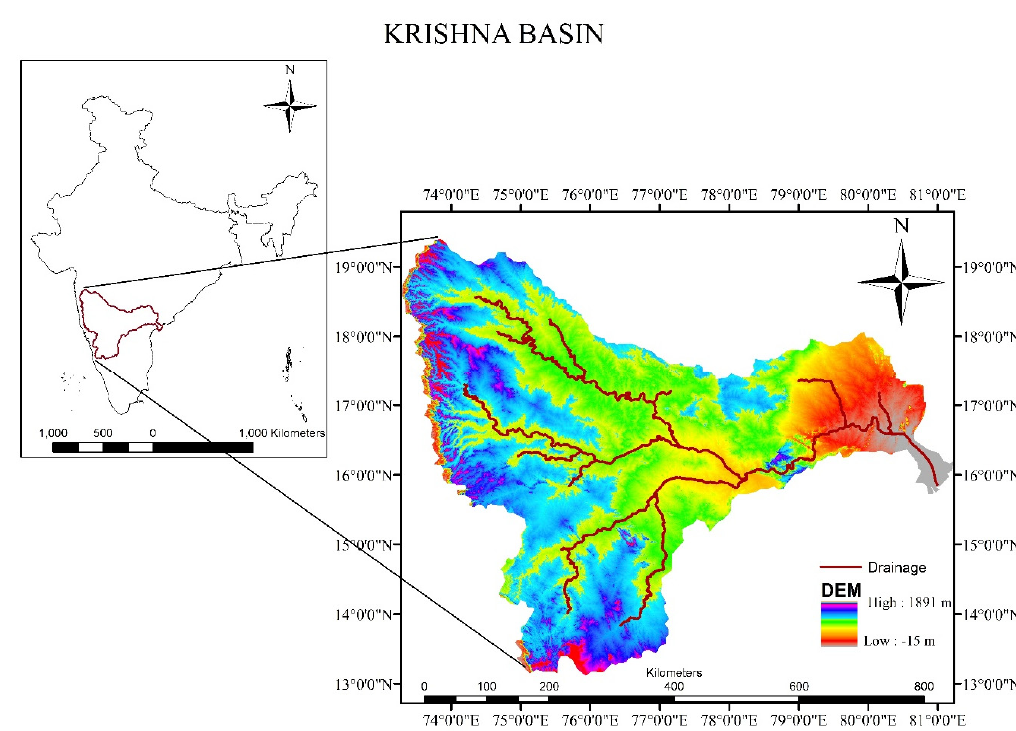
Figure 1. Location map of the Krishna River basin.